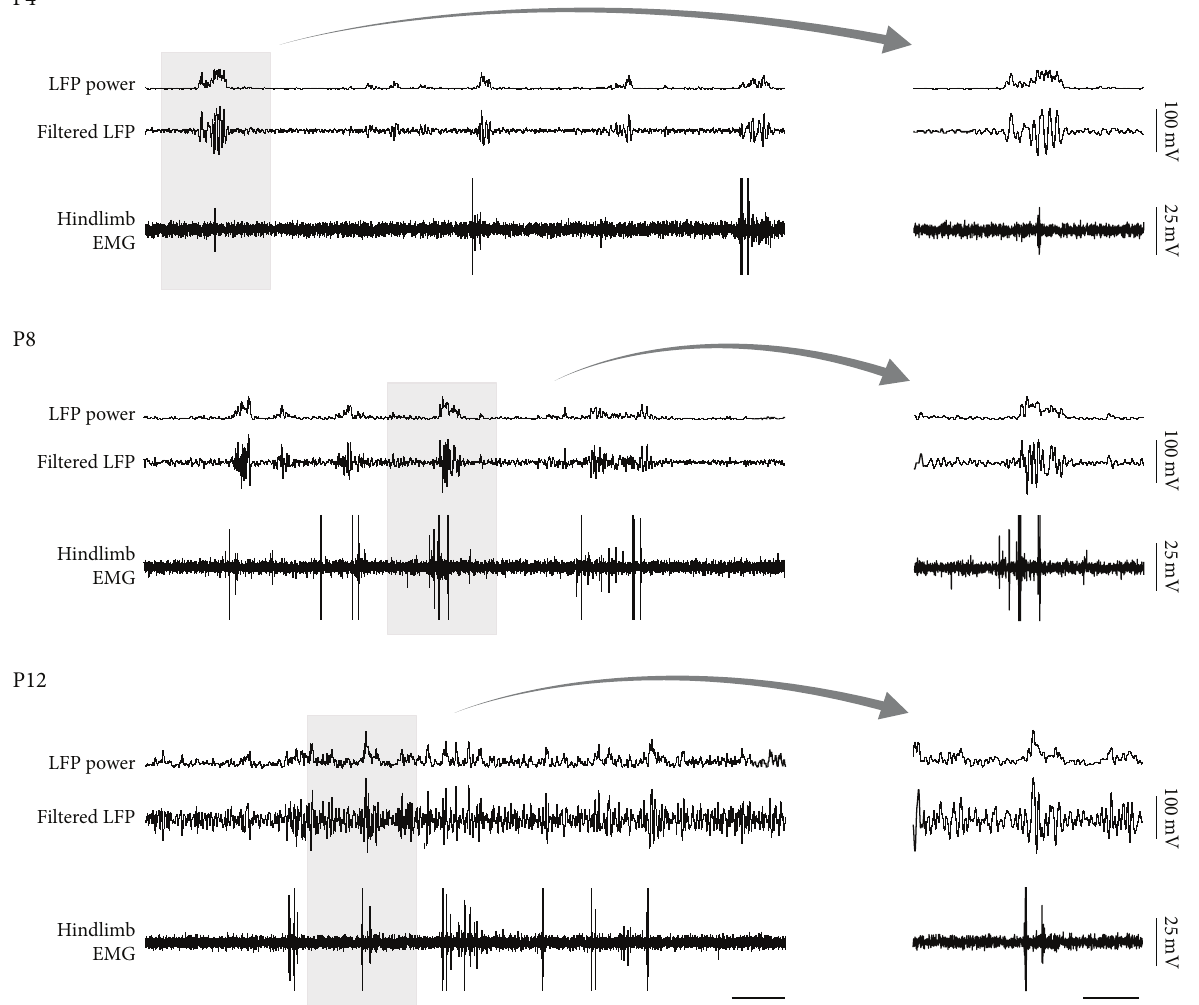
Figure 1: Spindle burst activity in motor cortex during REM sleep across the first two postnatal weeks in P4, P8, and P12 rats. At each age, the bottom trace is the hindlimb electromyogram (EMG), the middle trace is the band-pass filtered (1–40Hz) local field potential (LFP) recorded from the hindlimb region of motor cortex, and the top trace is the root-mean-square (RMS; 𝜏 = 10 ms) of the LFP trace. The records in the gray boxes are expanded at